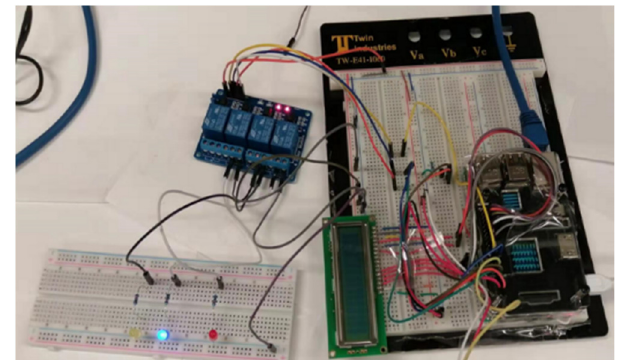
Figure 3. The system setup for mimicking the HVAC